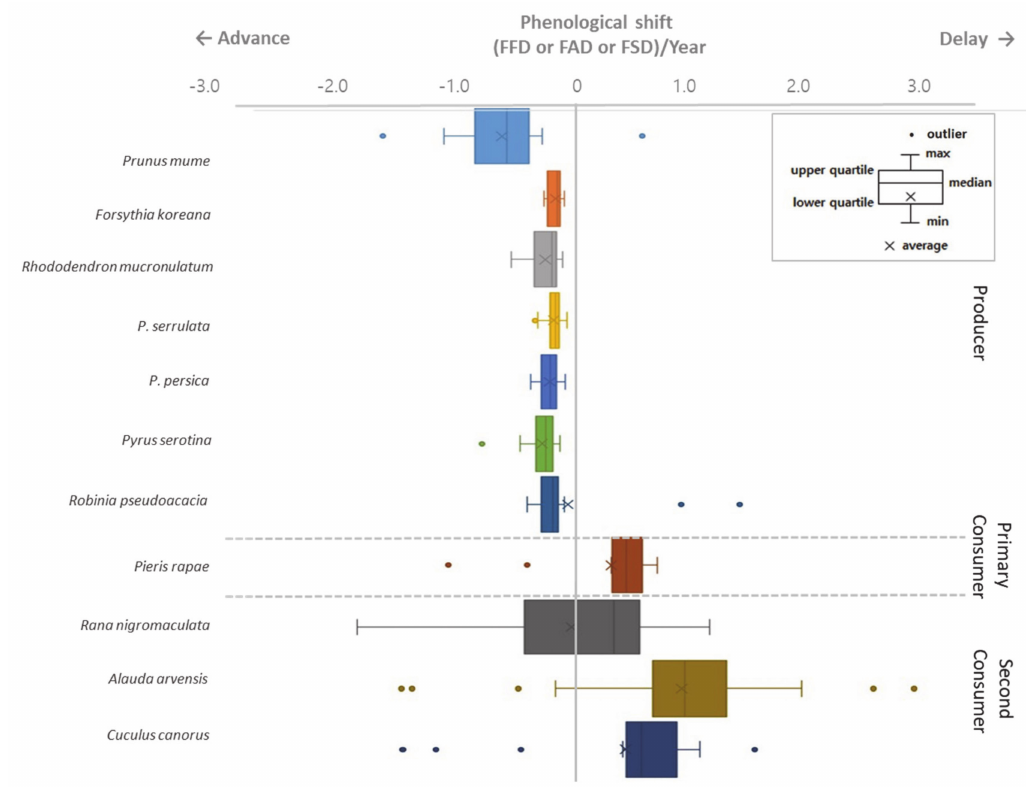
Figure 2. Phenological shift during 1976~2015 for each species with trophic structure of producer and primary and secondary consumers. The phenological shift represents the range of significant coefficient values for each species. The meaning of the boxplot is explained in the picture. (FFD = First Flowering Date, FAD = First Appearance Date, FSD = First Singing